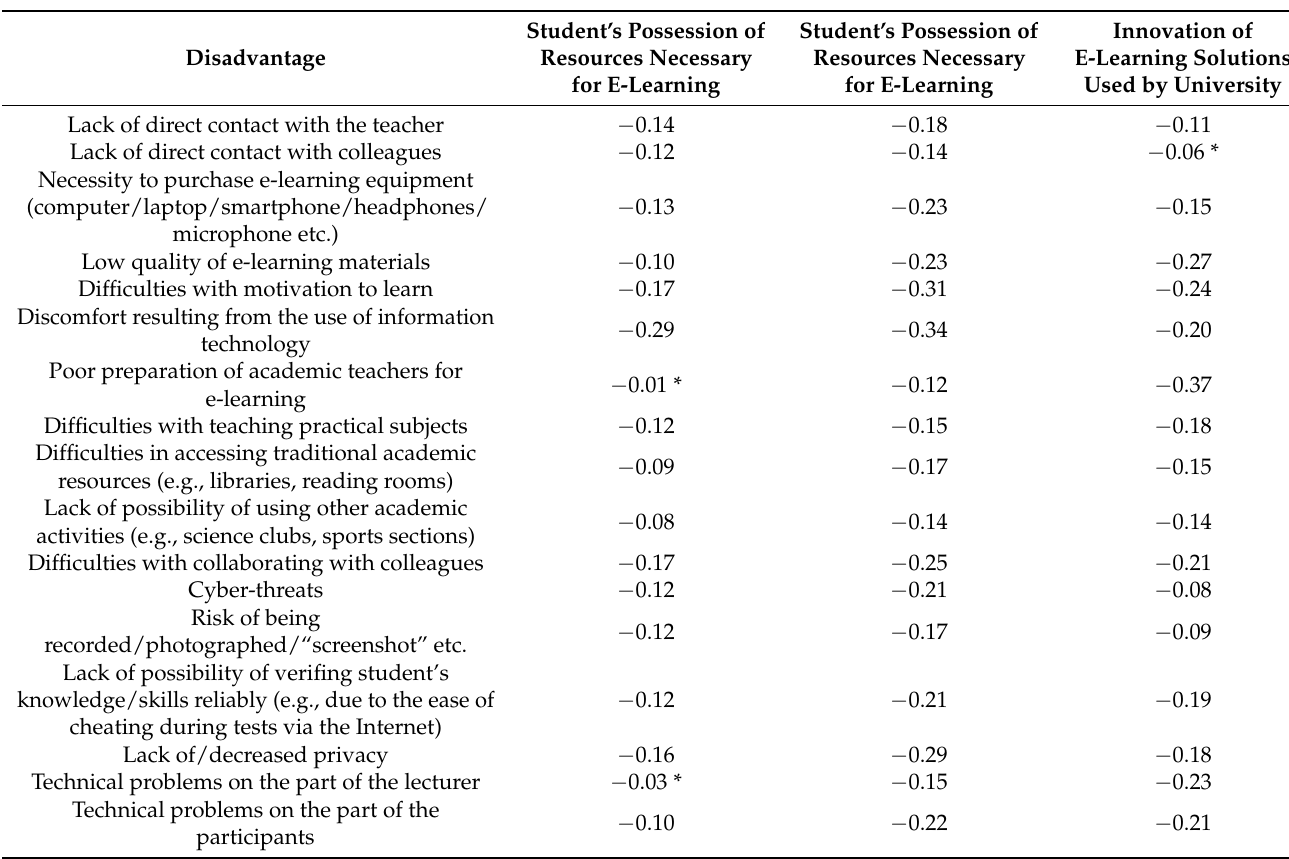
Table 7. Sperman’s rank correlations between the disadvantages of using e-learning and student’s knowledge of information technology, student’s possession of resources necessary for e-learning, and innovation of e-learning solutions used by university in which the given student